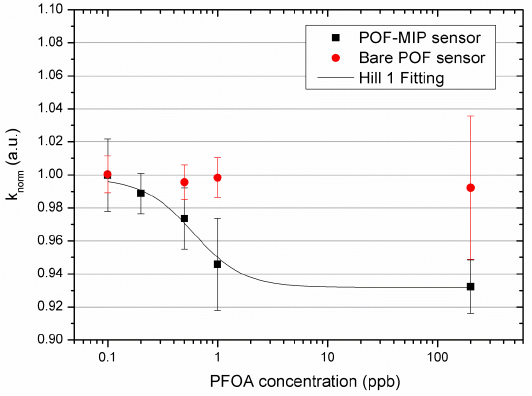
Figure 4. Response variation (respect to 0 ppb PFOA) versus the PFOA concentration (c), in semi-logarithmic scale, with the Hill Fitting, for the characterized D-shaped POF sensors (with and without the MIP layer).